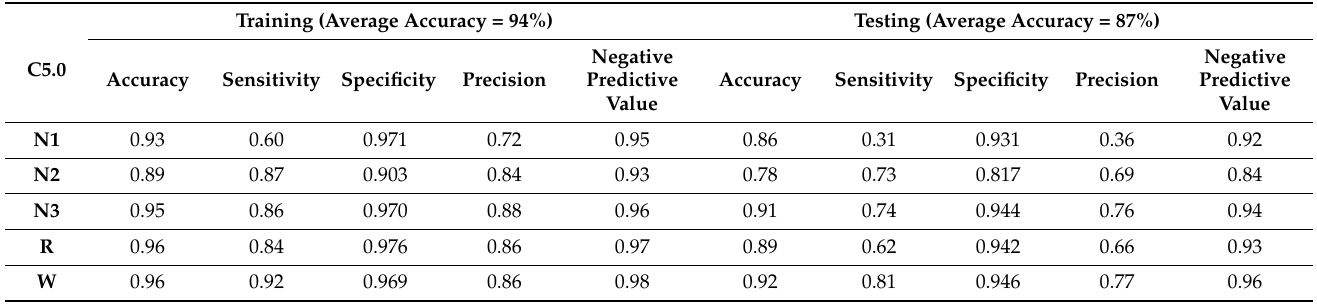
Table 7. Classification Performance parameters of the C5.0 Model using training and testing datasets